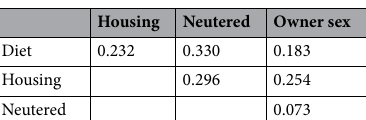
Table 2. Correlation factors between variables (Fisher’s Exact